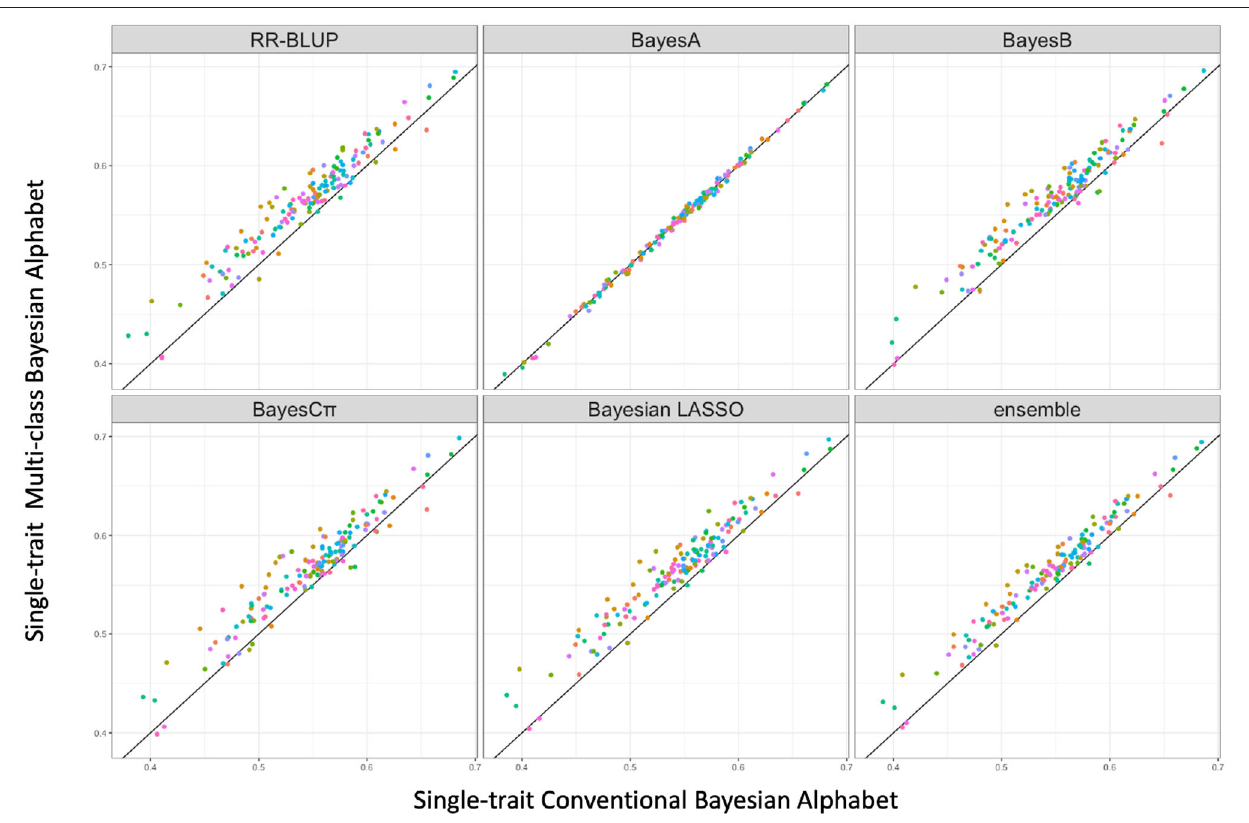
Frontiers in Genetics |